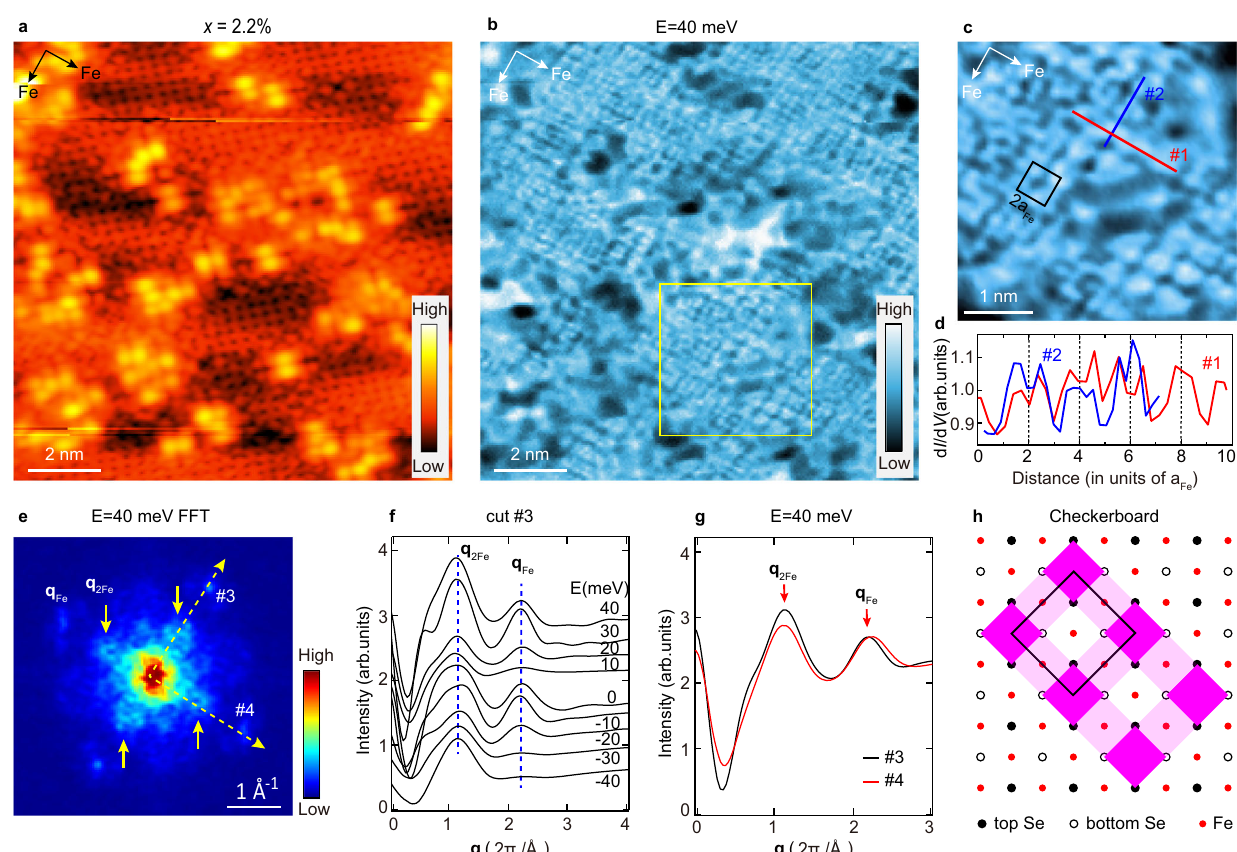
Fig.3|SpatialLDOSmodulationsinanFe 1 − x Seregionwith x =2.2%.a Atomically various energies. A fi tted Lorentz-shaped background was subtracted for each curve, and the curves were shifted vertically for clarity. The two blue dashed lines resolved topographic image ( V b =40mV, I t =20 pA). b Typical d I/ d V map at E =40meV (setpoint: V I Δ V =2mV). c Enlarged image of the indicate the positions of q Fe and q 2Fe . g Comparison of FFT line cuts at E =40meV b =40mV, t =50 pA, area marked by yellow box in ( b ). The black box shows the unit cell of the check- extracted along cuts #3 and #4in ( e ). h Schematic illustration of the fi ne structure erboard patternwith a 2a Fe period. d SpatialLDOS pro fi lestakenalong cuts #1and ofthecheckerboardpatternatoptheFeandSelattices.Unitcellofthisstructureis #2 in ( c ). e FFT image of the d I/ d V map in ( b ). Additional FFT features around q 2Fe indicated by black box. The magenta squares represent higher LDOS observed by are marked by yellow arrows. f FFT line cuts extracted along cut #3 in ( e ) under STM, and the dark and light colors show difference in LDOS